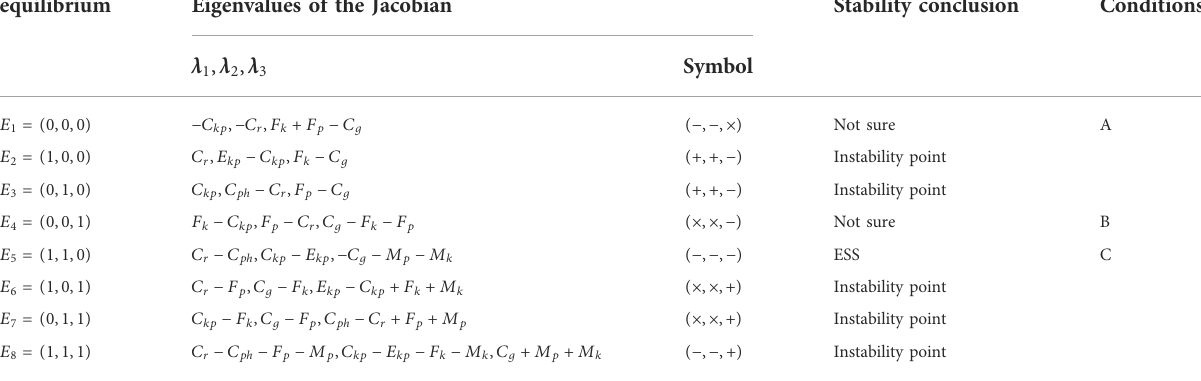
TABLE 2 Stability analysis of equilibrium points of the three-party evolutionary game system. equilibrium Eigenvalues of the Jacobian